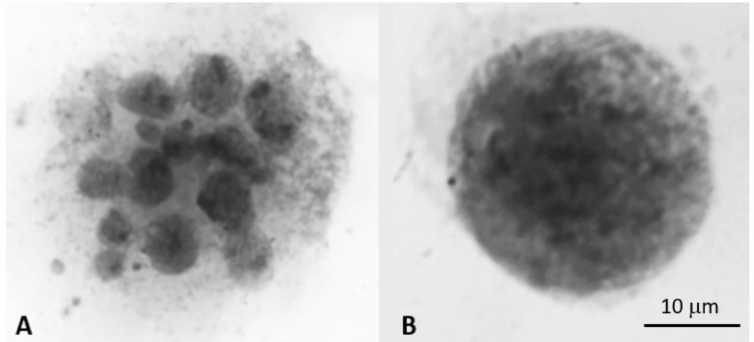
Figure 1. Example of the micronuclei cluster. A ) represents a micronuclei cluster (with a dozen of smaller nuclei) induced from Doxorubicin (2 µ g / mL, for 2 h) treated mouse ovarian surface epithelial (Brca1 - / - and p53- / -) cells. For the treatment details please see Liu et al., 2014 [11]. B ) represents a normal size nucleus from the control group. Both images are reversed DAPI (4 (cid:48) ,6-diamidino-2-phenylindole, a fluorescent DNA stain) images. The high frequencies of micronuclei clusters can be induced from di ff erent drugs or treatments including inhibitor of the Aurora B kinase, and various irradiations.